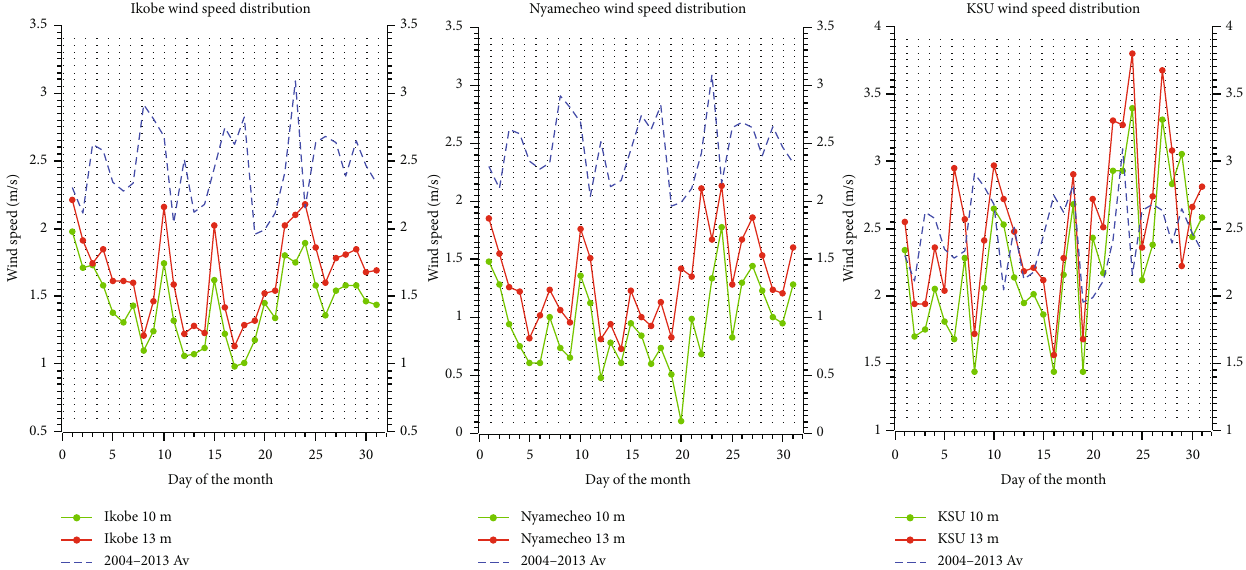
Figure 5: March ’ s wind speed distribution pattern in comparison to 10 years of distribution.